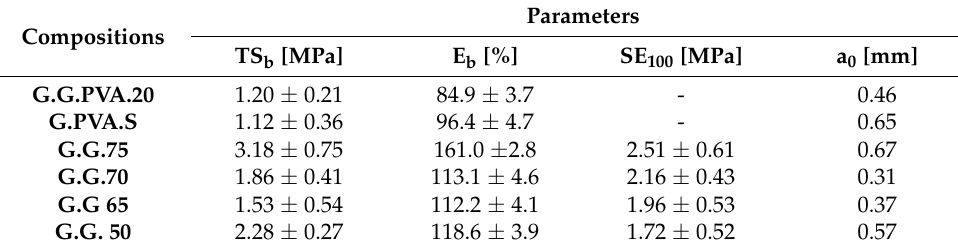
Table 4. Results of mechanical measurements.